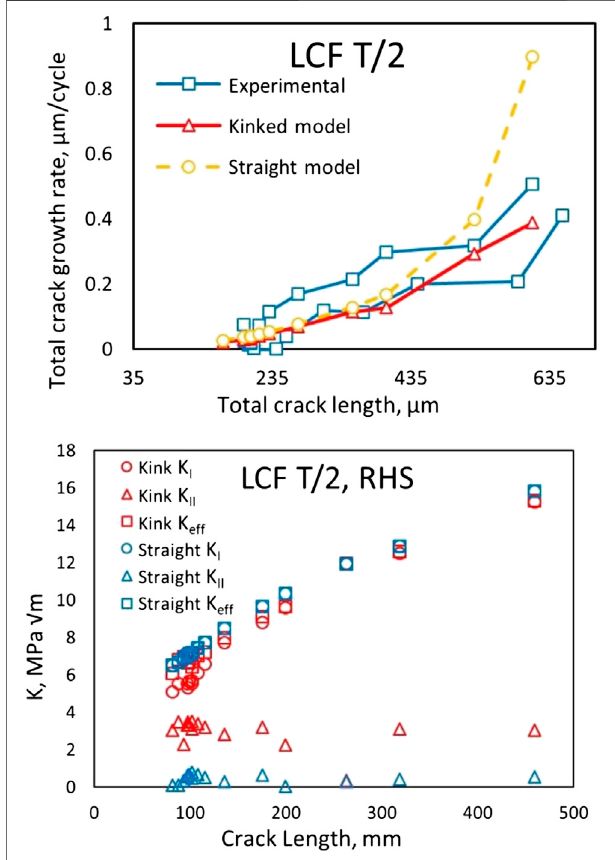
FIGURE10|(A) Comparison ofpredictedFCGR fortwoLCF T/2 model con fi gurations:acrackwithasinglekinkandstraightcrack (B) Comparisonof predicted FCGR (modes I, II, and effective) for the same two con fi